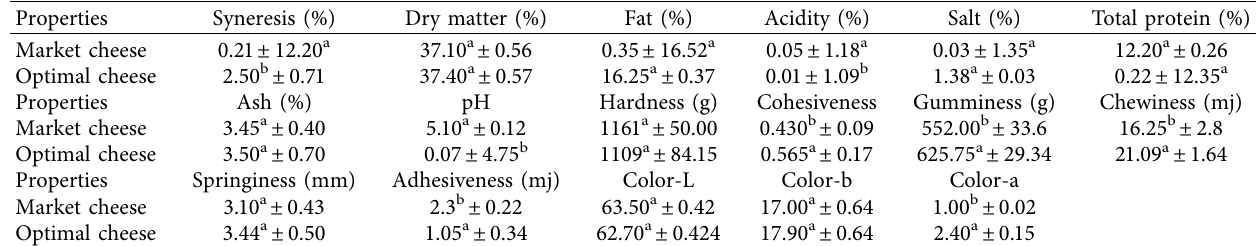
Table 3: Physicochemical characteristics of market Feta cheese and optimal cheese ∗ .